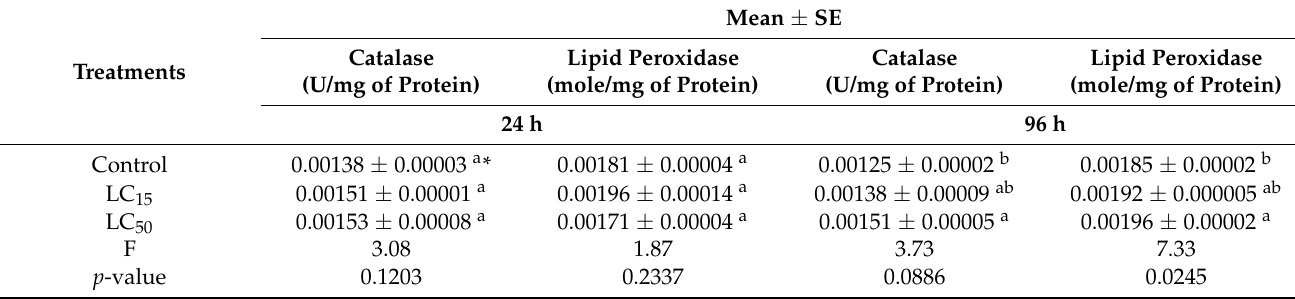
Table 5. Mean ( ± SE) of catalase, and lipid peroxidase enzyme activity of A. ipsilon after 24 and 96 h of 2nd-instar larvae being exposed to LC 15 and LC 50 values of C. citratus essential